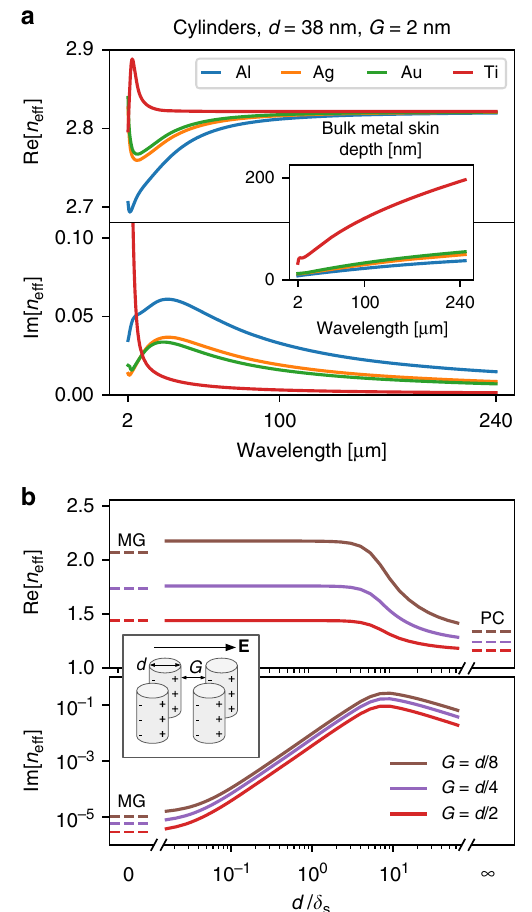
Fig. 4 Transparency as a function of skin depth. a The effective index of a square array of nanocylinders, composed of aluminium, gold, silver, and titanium. Inset: the skin depth of each metal, calculated using the Lorentz – Drude model of permittivity with data from Rakic et al. 29 . b At a fi xed wavelength, it is the ratio of the particle diameter to the skin depth of the metal that determines whether the particles behave as quasi-static dipoles or perfect conductors. The effective index is remarkably